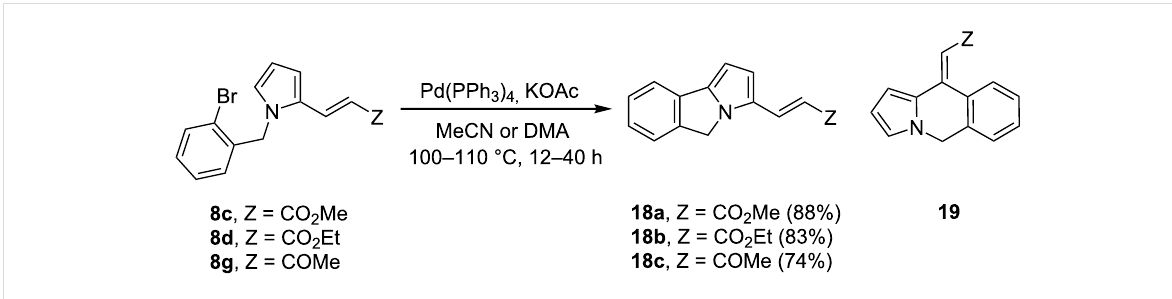
Scheme 4: Pd(0)-catalyzed intramolecular Heck cross-coupling reaction of 2-vinylpyrroles 8c , d and 8g .